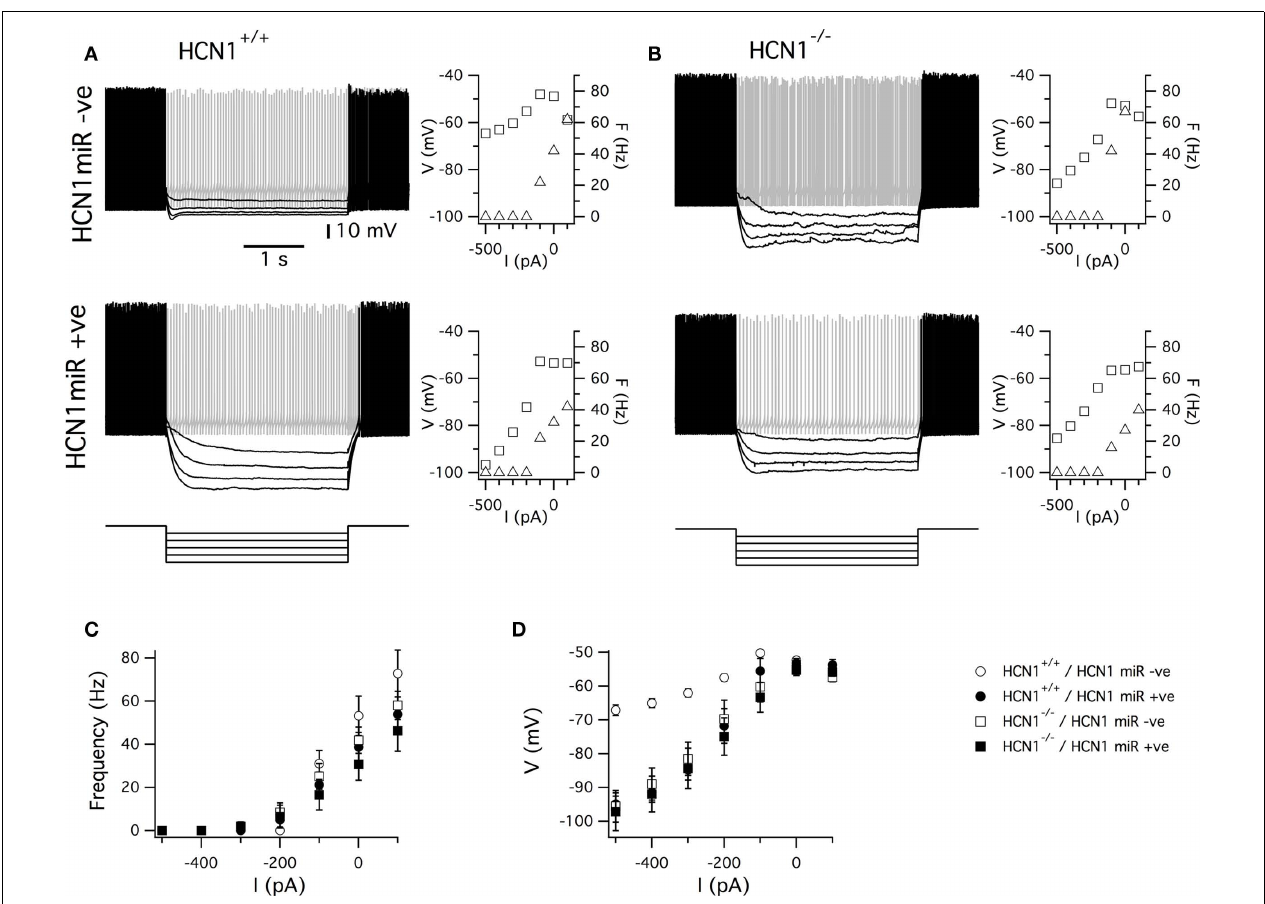
frequency (C) and modal membrane potential (D) as a function of the amplitude of the test current step.There was no significant effect ( p < 0.05) of genotype or AAV expression on the spike frequency at any amplitude of current step. In contrast, the amplitude of the membrane potential change depended on genotype and AAV expression (for − 500pA current steps, p = 0.0061 for genotype, p = 0.0044 for AAV infection, and p = 0.0050 for interaction between AAV infection and genotype). Numbers of neurons and mice are as in Figure 6